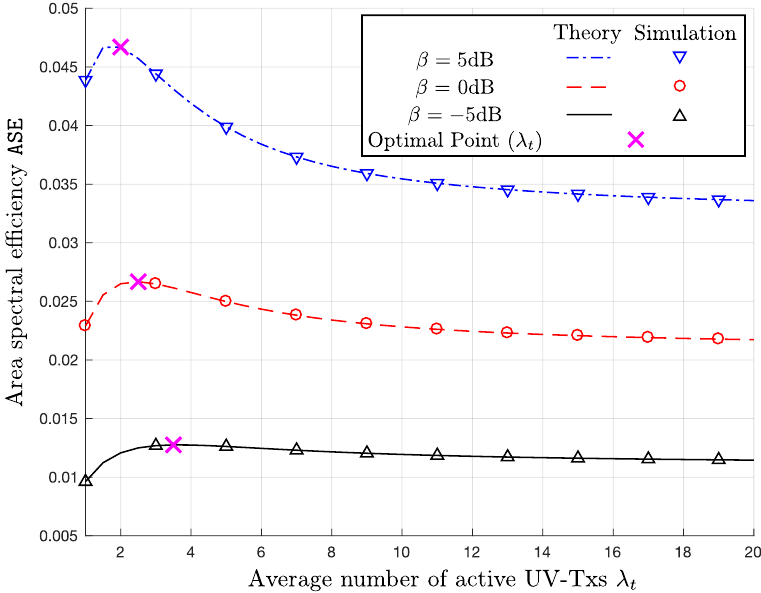
Figure 7. ASE versus λ t with λ c = 30 clusters/km, σ = 5 and β = {− 5,0,5 }